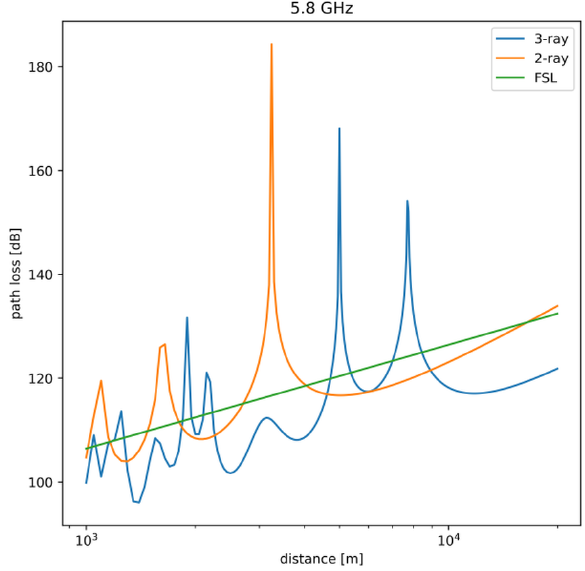
Figure 2. Propagation models